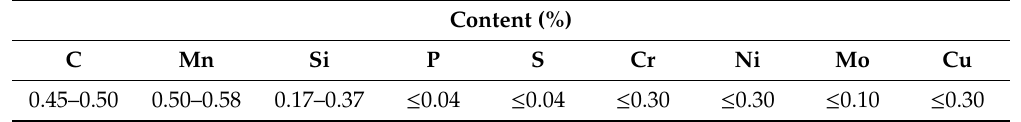
Table 2. Chemical composition of the C45 steel [1].